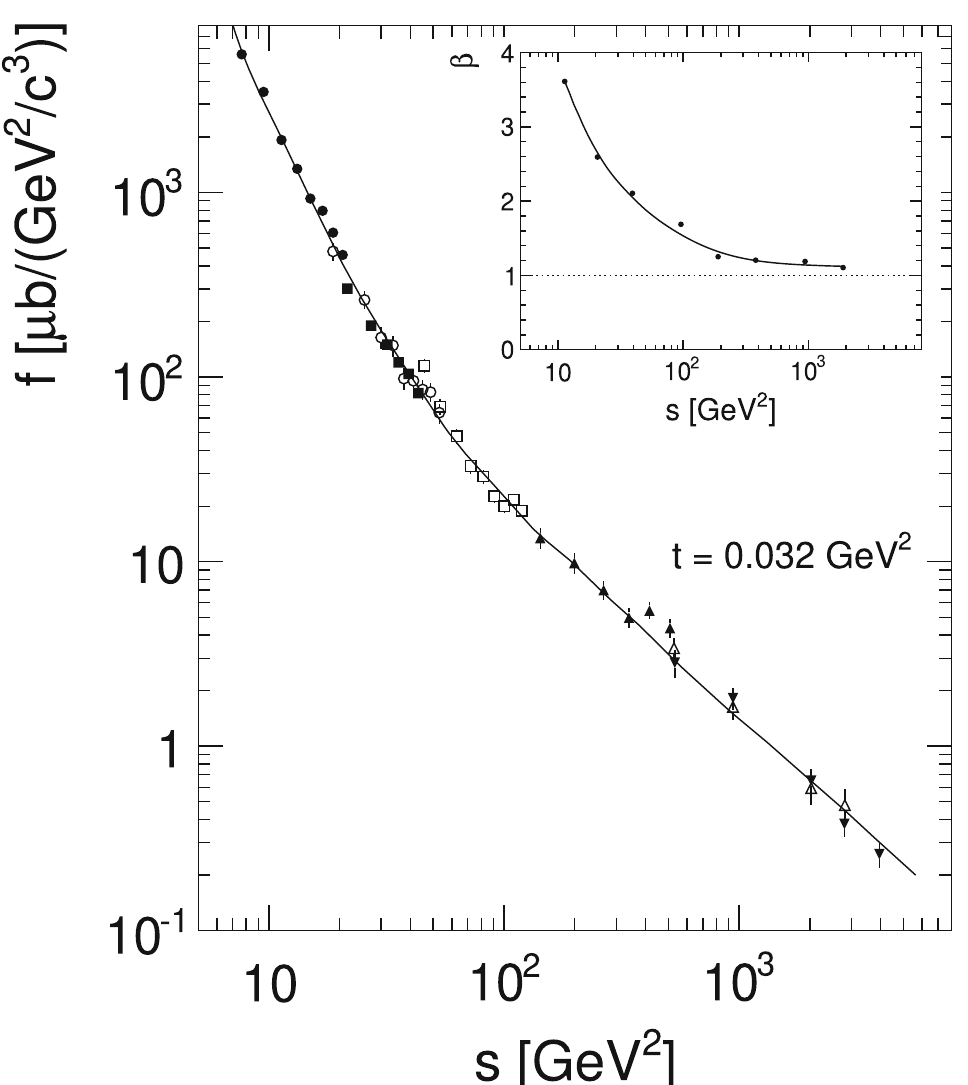
Fig. 165 Invariant cross sections of charge exchange and single and double dissociation in nucleon-nucleon interactions as a function of s at a momentum transfer t = 0.032 GeV 2 . The full line represents an